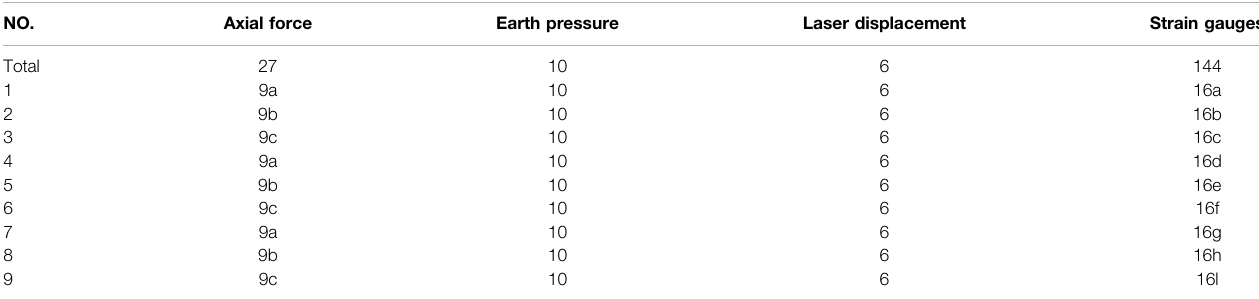
TABLE 3 | Number of sensors and grouping acquisition scheme.